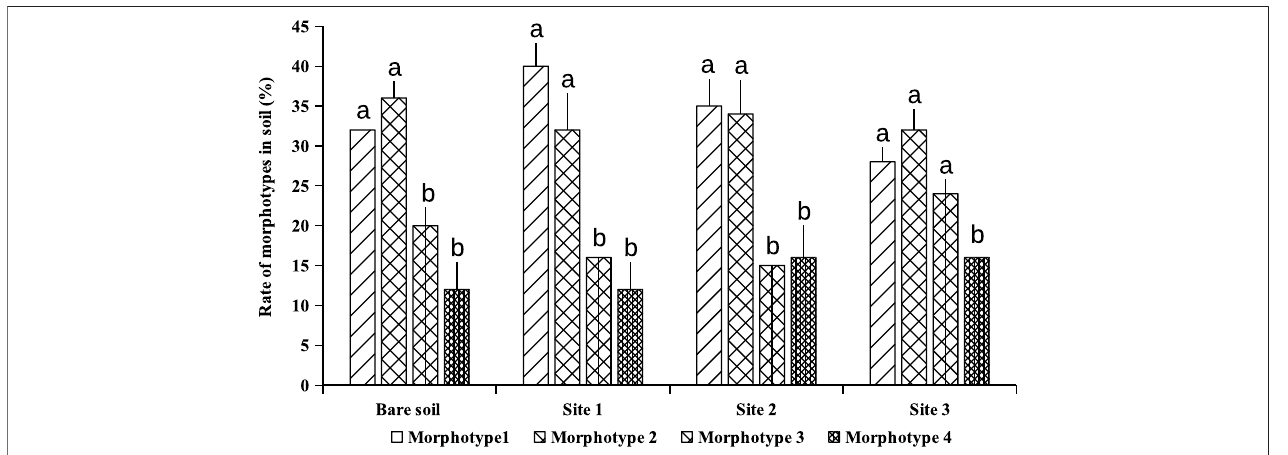
( Figure 3 ). The study of the morphological diversity of mycorrhizal fungi associated with the rhizospheric soil of A.